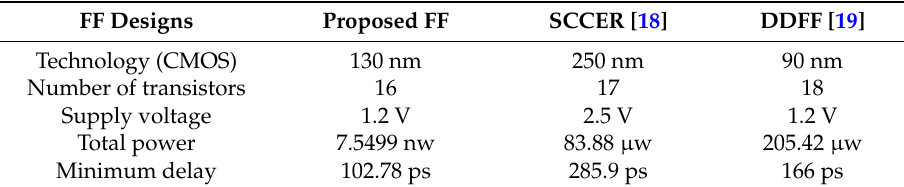
Table 1. Performance summary of flip-flops compared with other